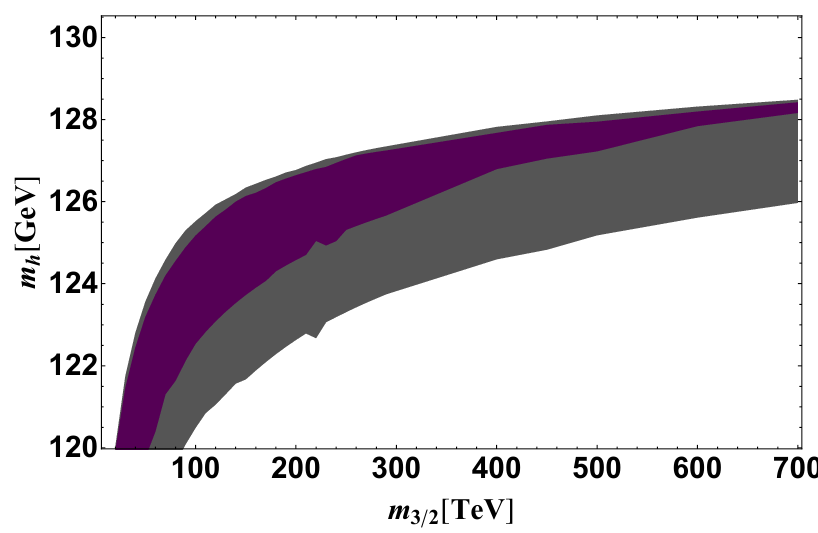
Figure 5 . The Higgs boson mass for the neutralino LSP region (purple band) and the region with vacuum stability (gray band). The ranges of the parameters are same as in (cid:12)gure